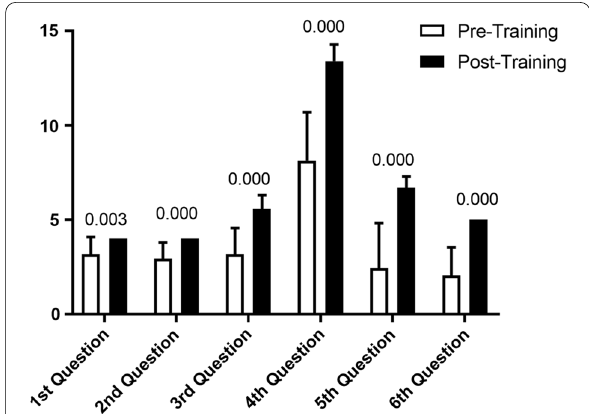
Fig. 2 Reassessment of Arabic Reading Achievement Test (ARAT) of the trainee sample. Reassessment of Arabic achievement level of the trainee sample ( N 16 students) revealed significant improvement in = the total and all sub-items of Arabic achievement